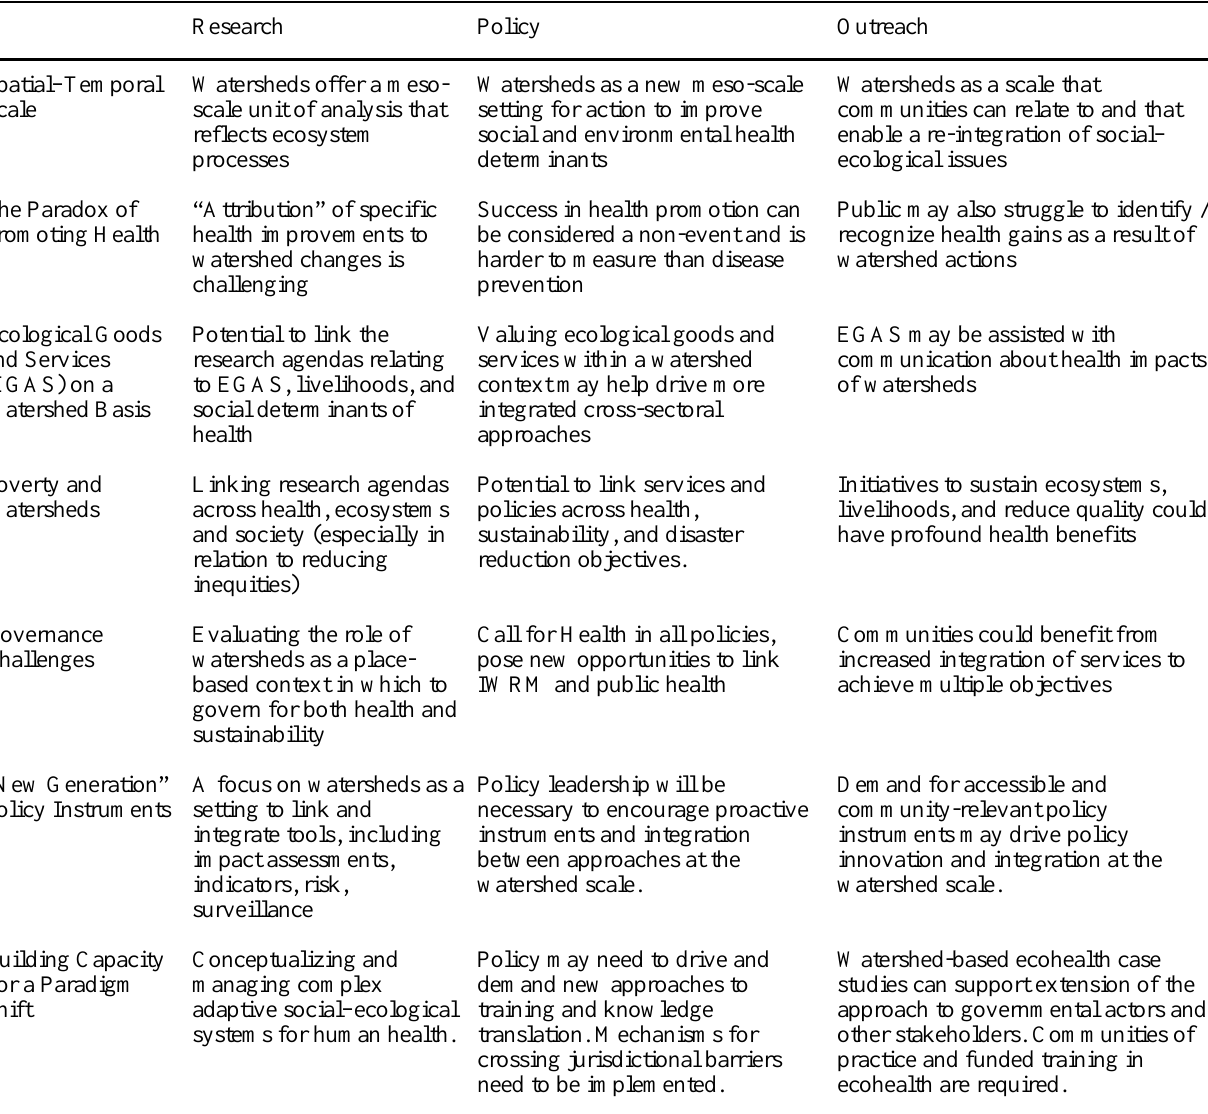
Table 2. Key challenges and opportunities associated with the integration of watersheds and ecohealth (Parkes et al.